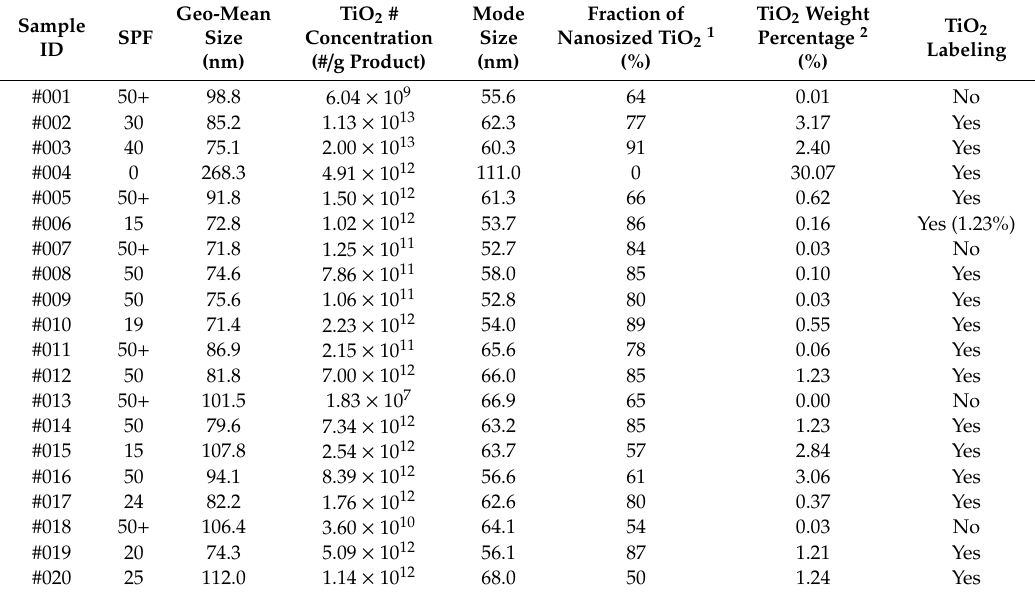
Table 1. Size, number, and weight concentration of TiO 2 in sunscreens by SP-ICP-MS.